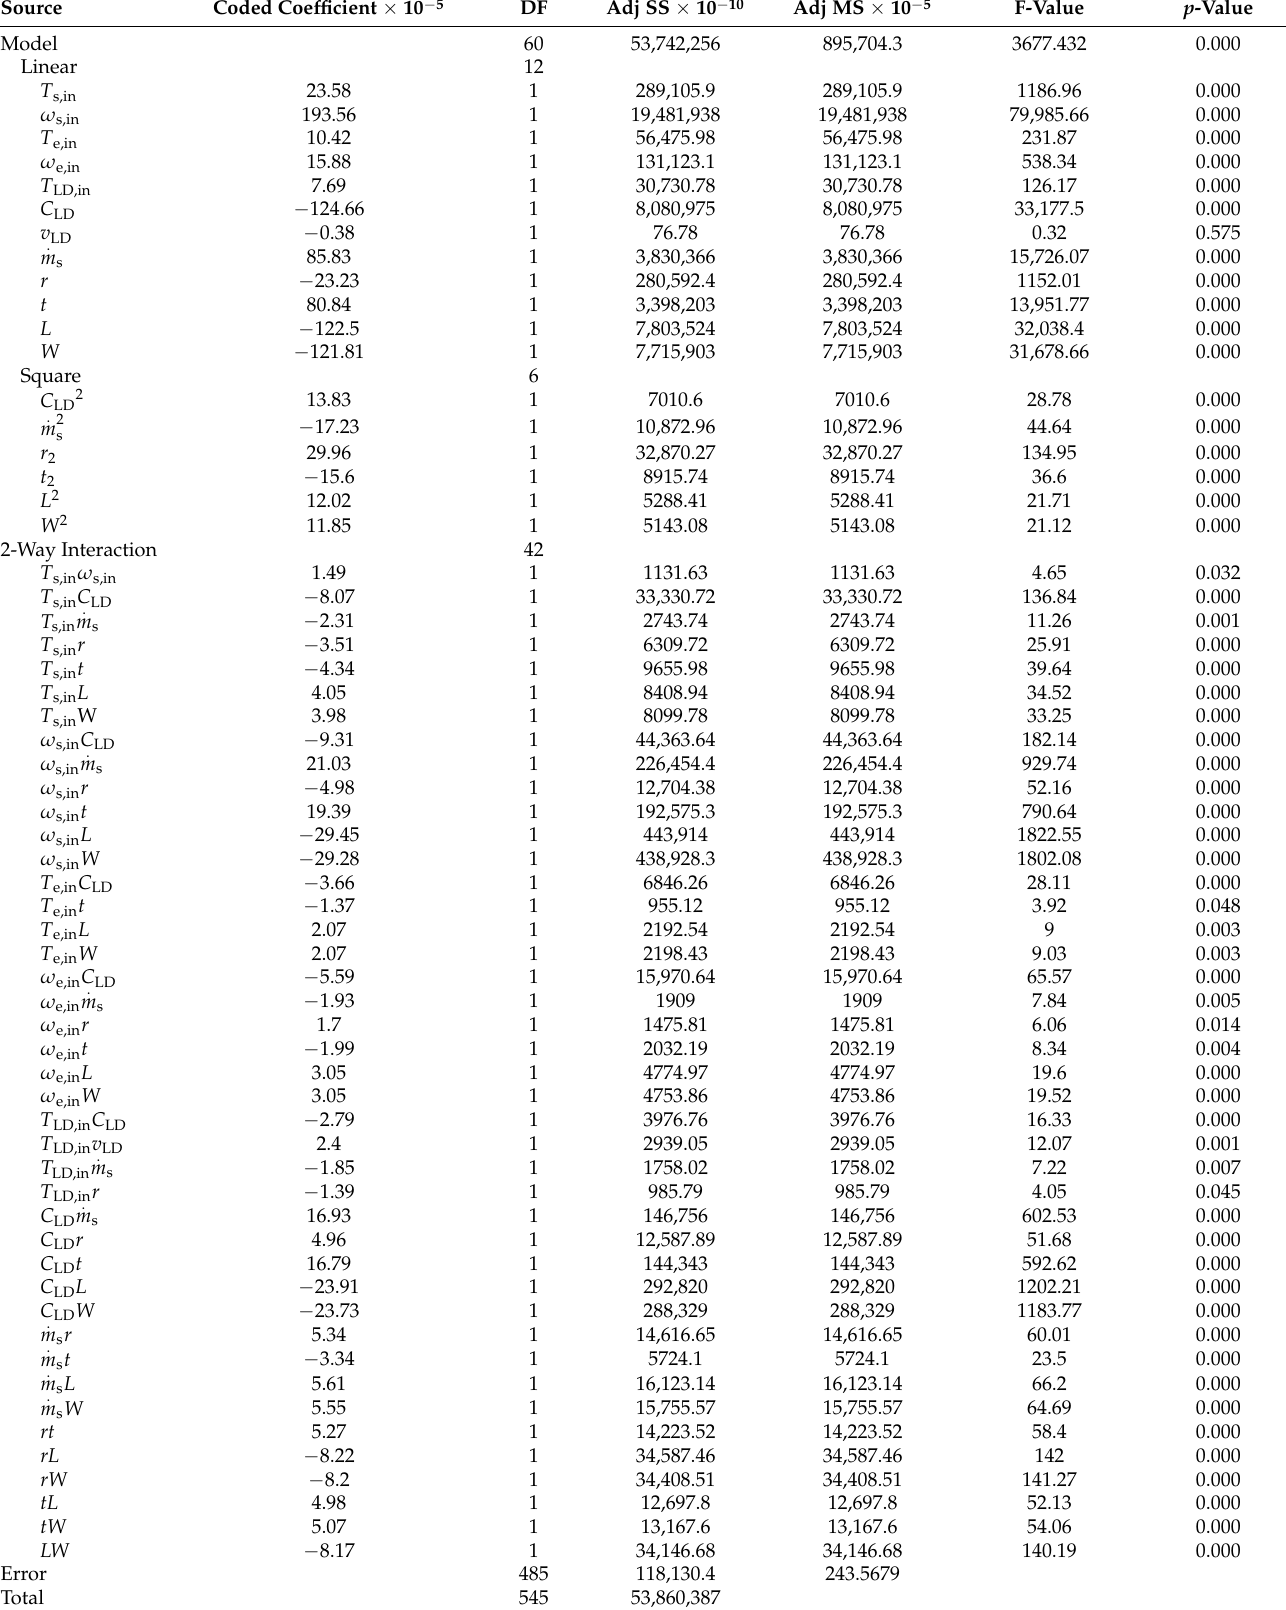
Table A2. ANOVA for the supply air outlet humidity ratio regression